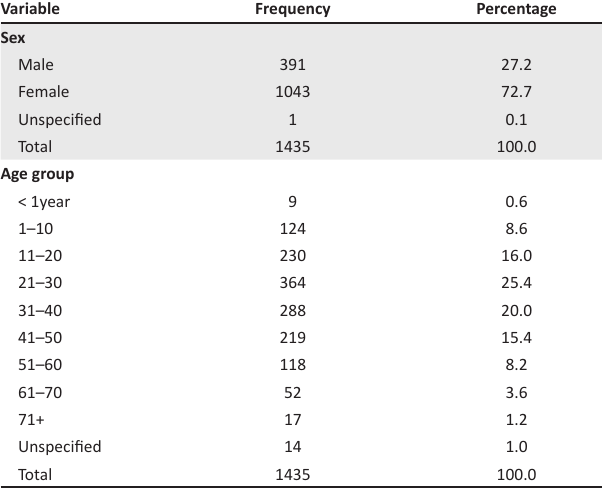
TABLE 1: Sex and age distribution of fine needle aspiration biopsy in